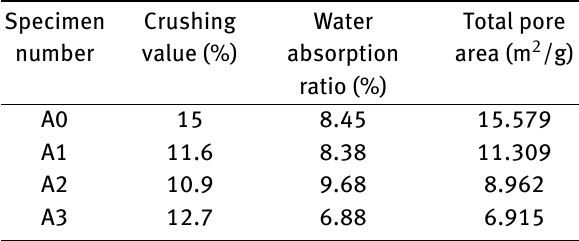
Table 2: Physical properties and total pore area of RAs with